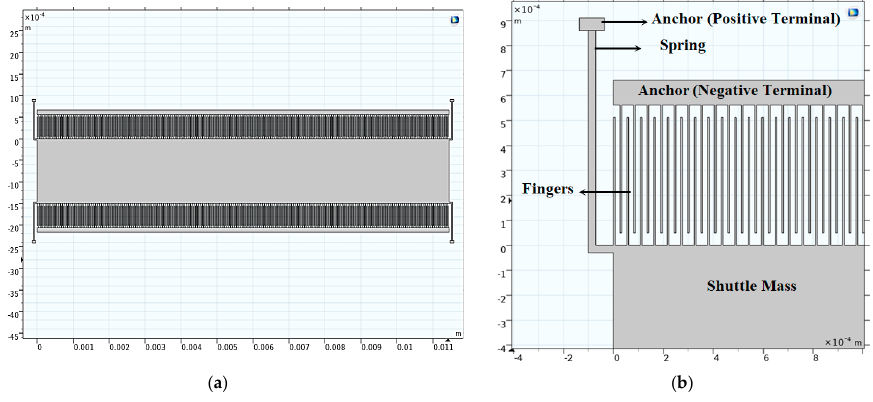
Figure 8. ( a ) The 2D converter structure and ( b ) a focus of the structure showing a clear view.